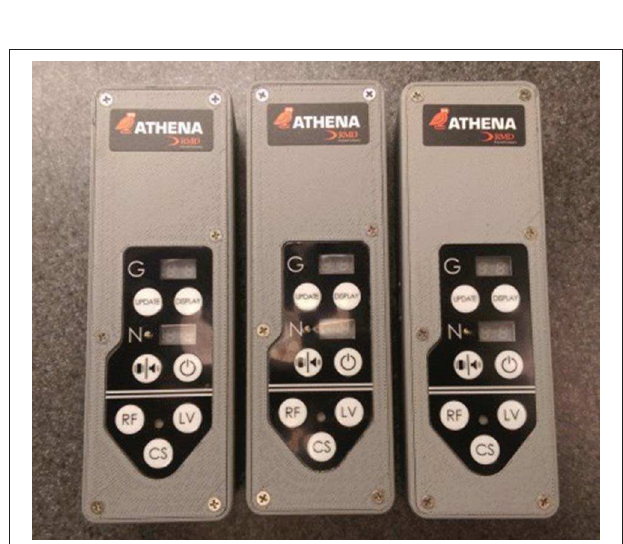
while the photopeak position is quite constant, the spectral shape does change. It is not clear whether this change is due to bulk or surface